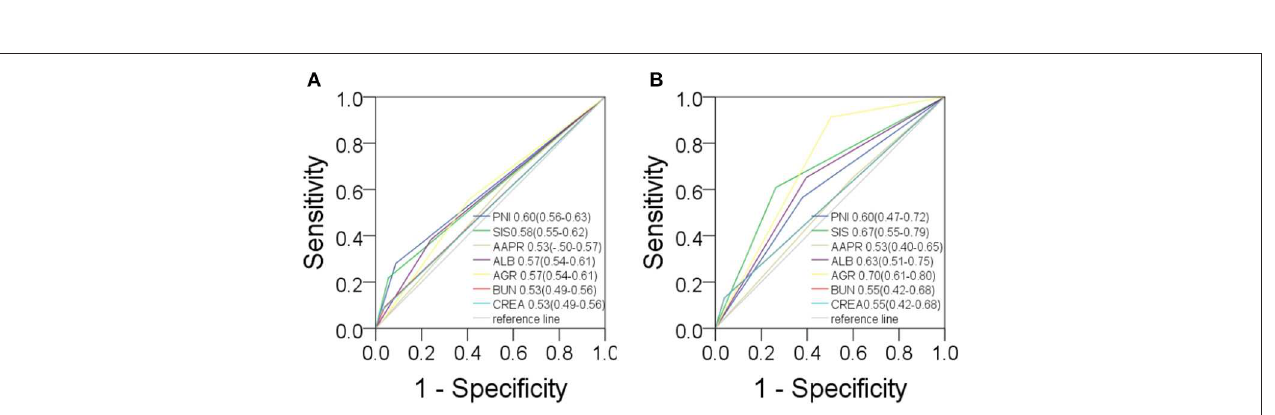
Frontiers in Oncology |